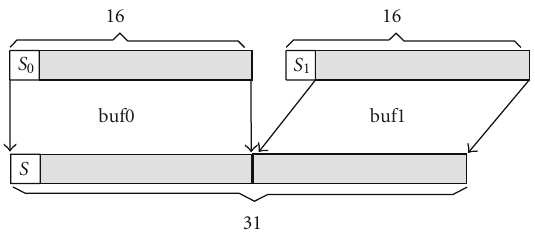
Figure 5: The storage data structure for